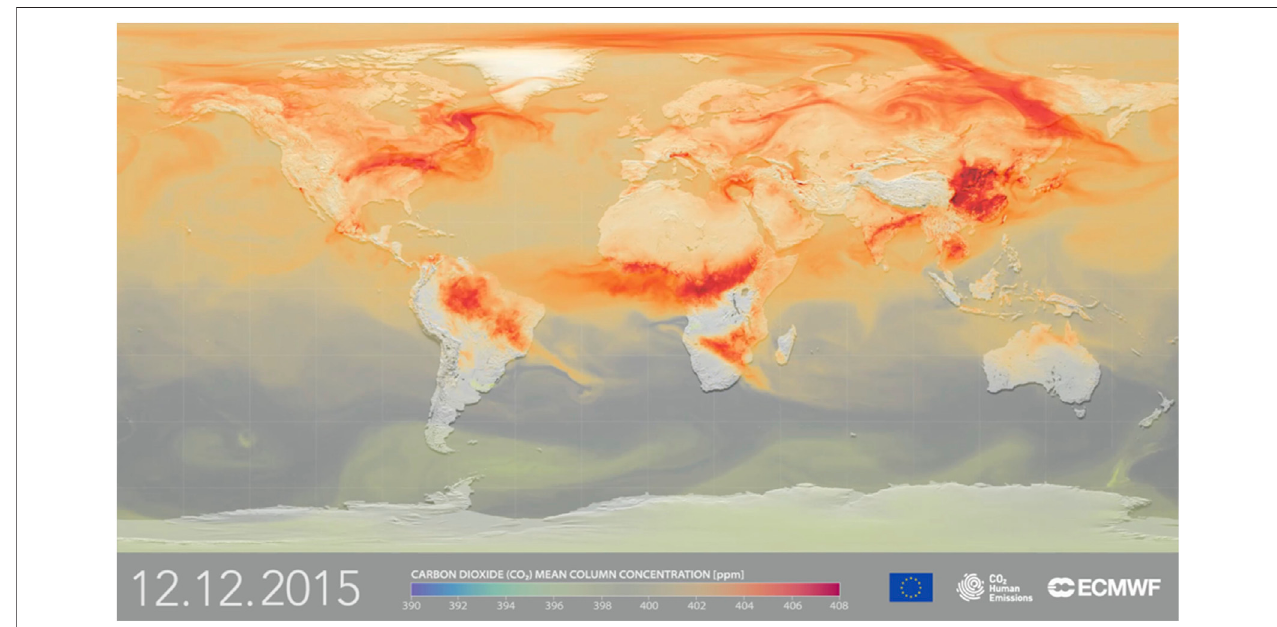
FIGURE 2 | Examples of the CHE Nature Run Tier-2 CO 2 concentrations valid for the December 12, 2015 obtained by global simulations with the ECMWF-IFS. Video for the whole 2015 available at https://www.che-project.eu/news/year-atmospheric-co2-variability-time-paris-agreement.